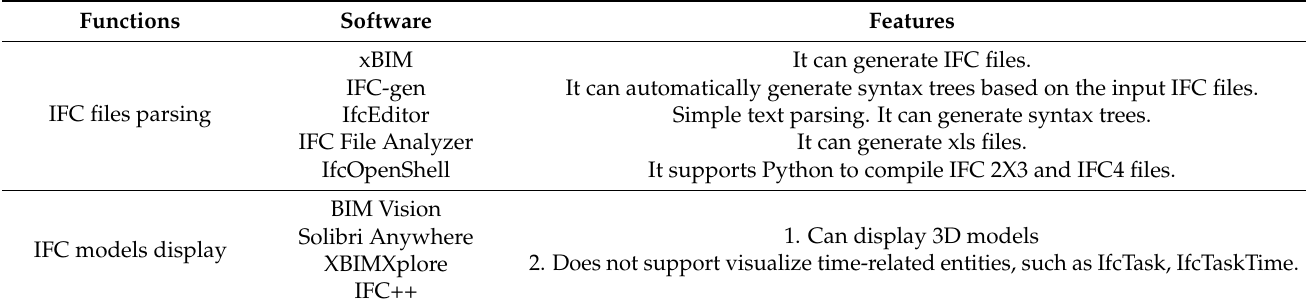
Table 1. Software for parsing IFC files and their